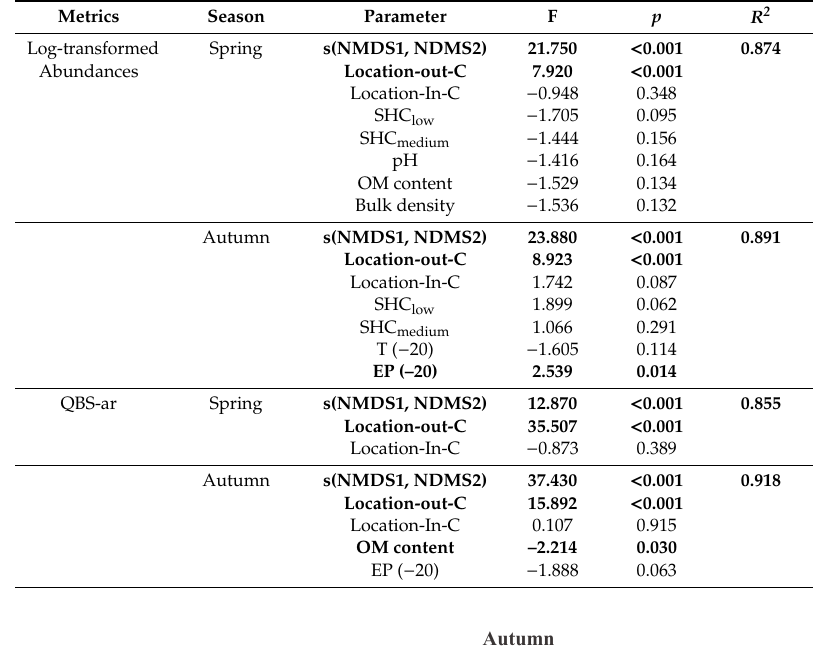
Table 4. GAMs results for community metrics in each season. Significant results are shown in bold. Location indicates where sampling stations were located: outside the canopy (Out-C) or beneath tree canopy (In-C); SHC-low / medium / high indicates the characteristics of environment and pressure of the livestock in which points were located; T (–20) = average temperature of the 20 days prior to sampling day; EP (–20) = e ff ective cumulative precipitation of the 20 days prior to sampling day.